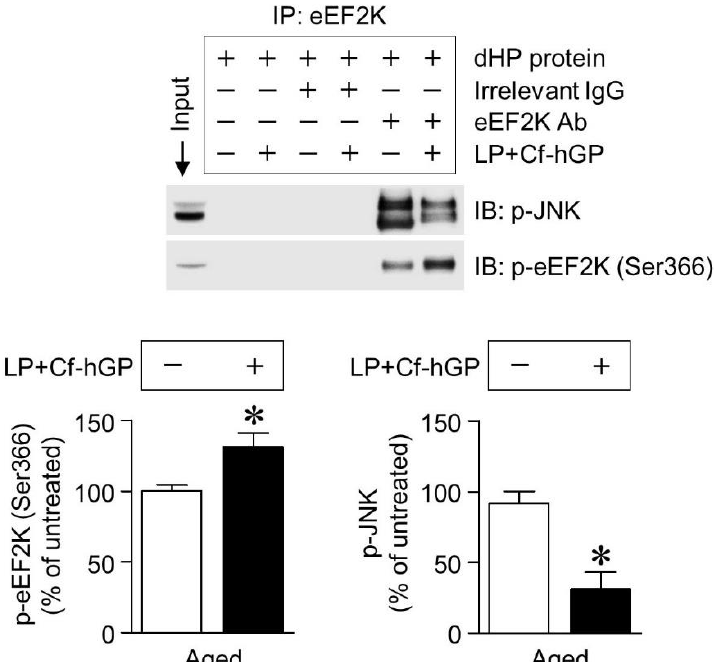
Figure 5. Effect of co-treatment with Cf-hGP and L. plantarum on the eEF2 kinase-JNK interaction. JNK was immunoprecipitated using the eEF2 kinase antibody. The interaction between the eEF2 kinase and JNK was downregulated by co-treatment with Cf-hGP and L. plantarum . Further, a significant decrease in JNK phosphorylation was accompanied by an increase in eEF2 kinase phosphorylation. * P < 0.05 versus untreated rats; unpaired t -test. Cf-hGP, Capsosiphon fulvescens glycoprotein; LP, Lactobacillus plantarum ; eEF2K, eEF2 kinase; dHP, dorsal hippocampus; IP, immunoprecipitation; IgG, immunoglobulin G; Ab, antibody.